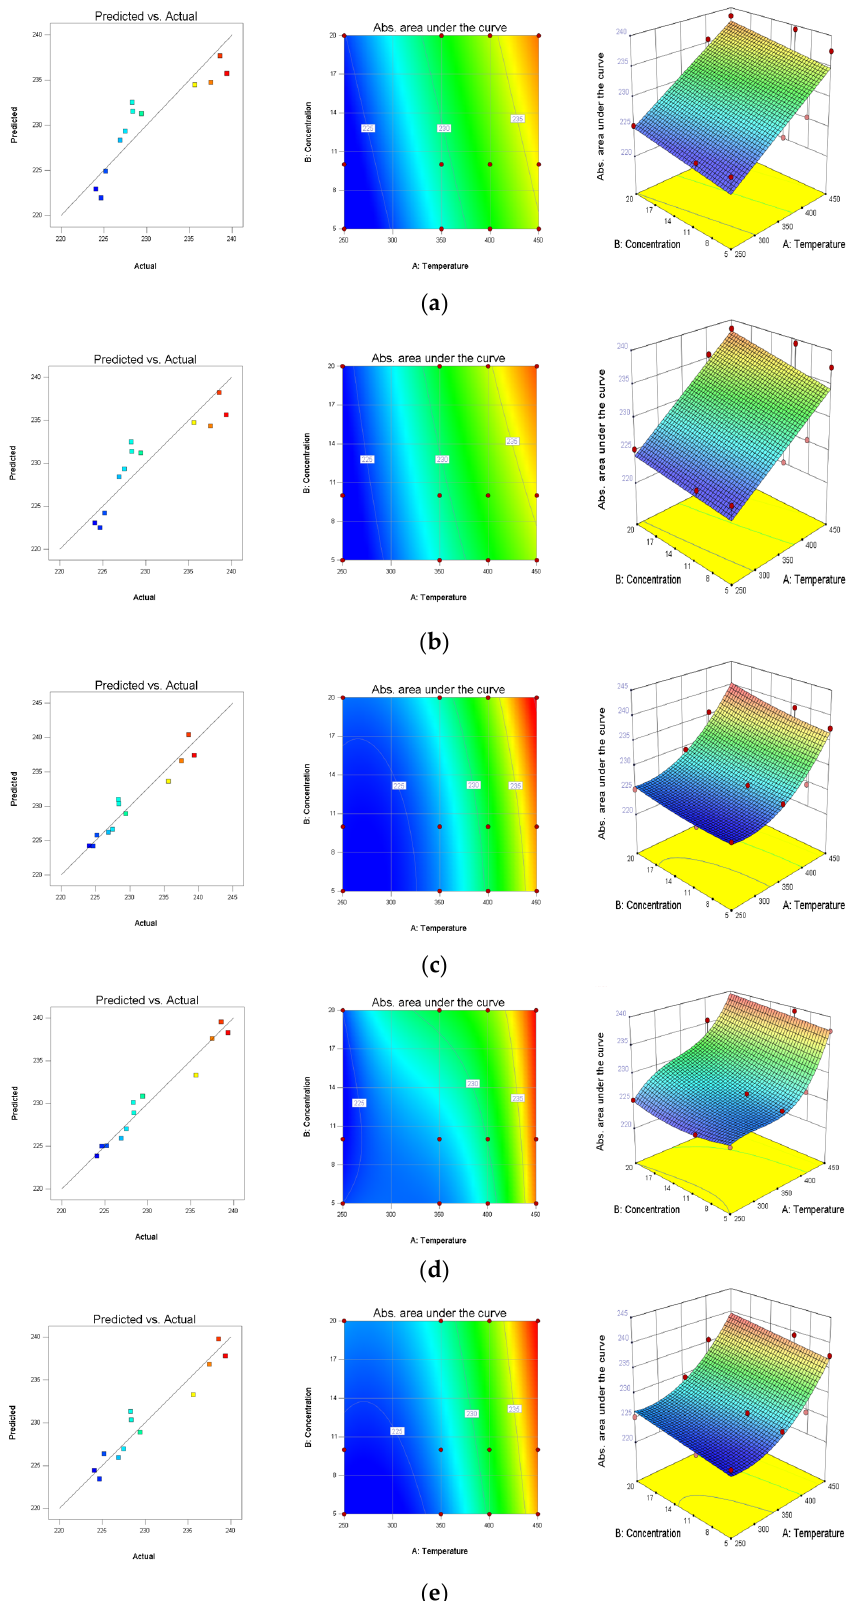
Figure 2. Comparison between the models: predicted vs. actual, contour and 3D curves. ( a ) Linear model, ( b ) 2FI model, ( c ) quadratic model, ( d ) cubic model, and ( e ) modified quadratic